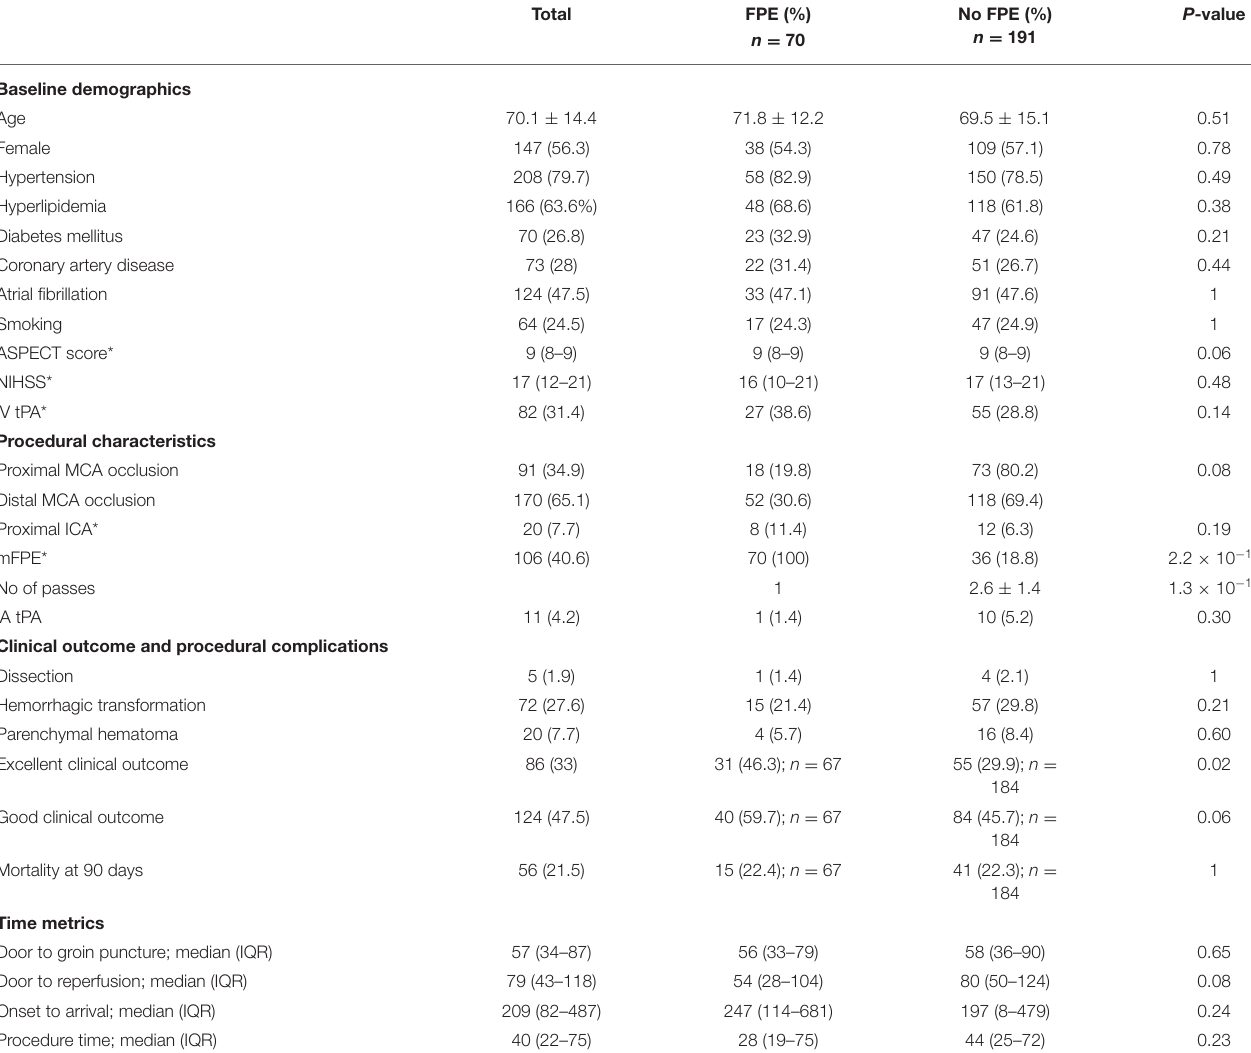
TABLE 1 | Baseline demographics, procedural characteristics, and clinical outcomes in patients with or without a first pass effect for MCA M1